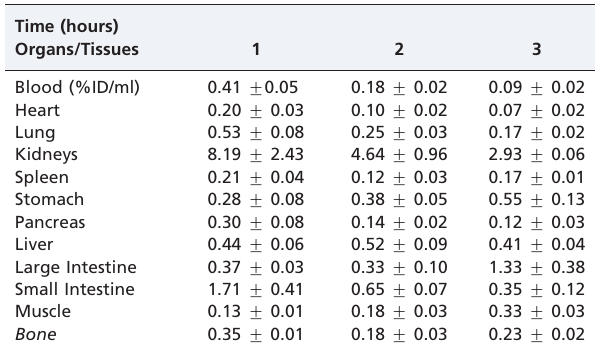
Figure 6 - Receptor binding to PC-3 cells of (SA + B-MORF + B-PEG- BBN) with 99m Tc-MAG 3 -cMORF.